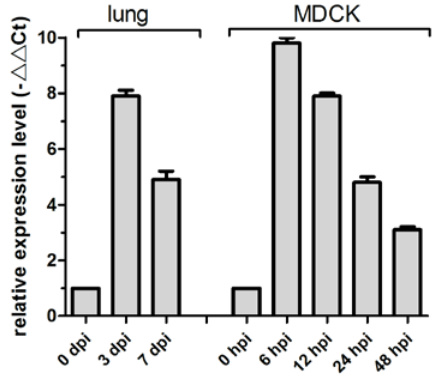
Figure 1. cfa-miR-143 expression was measured in canine influenza virus (CIV)-infected lungs and Madin-Darby Canine Kidney (MDCK) cells by real-time qPCR. The relative expression is depicted relative to the negative control at each time point. hpi: hour post-inoculation.